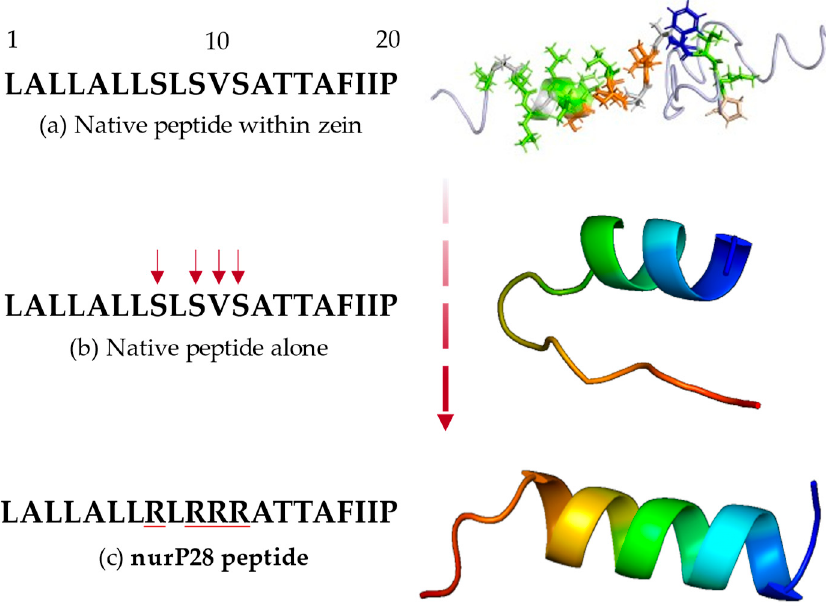
Figure 1. Design steps and molecular structure of nurP28 peptide. ( a ) Native peptide within zein protein; ( b ) native peptide alone showing the sequence unsuitable for synthesis; and ( c ) nurP28, the resulting modified peptide. Amino acid residues are colored according to the RasMol scheme within the zein structure. In each structure, red and blue ends indicate the C- and N-terminus of the represented peptide, respectively.